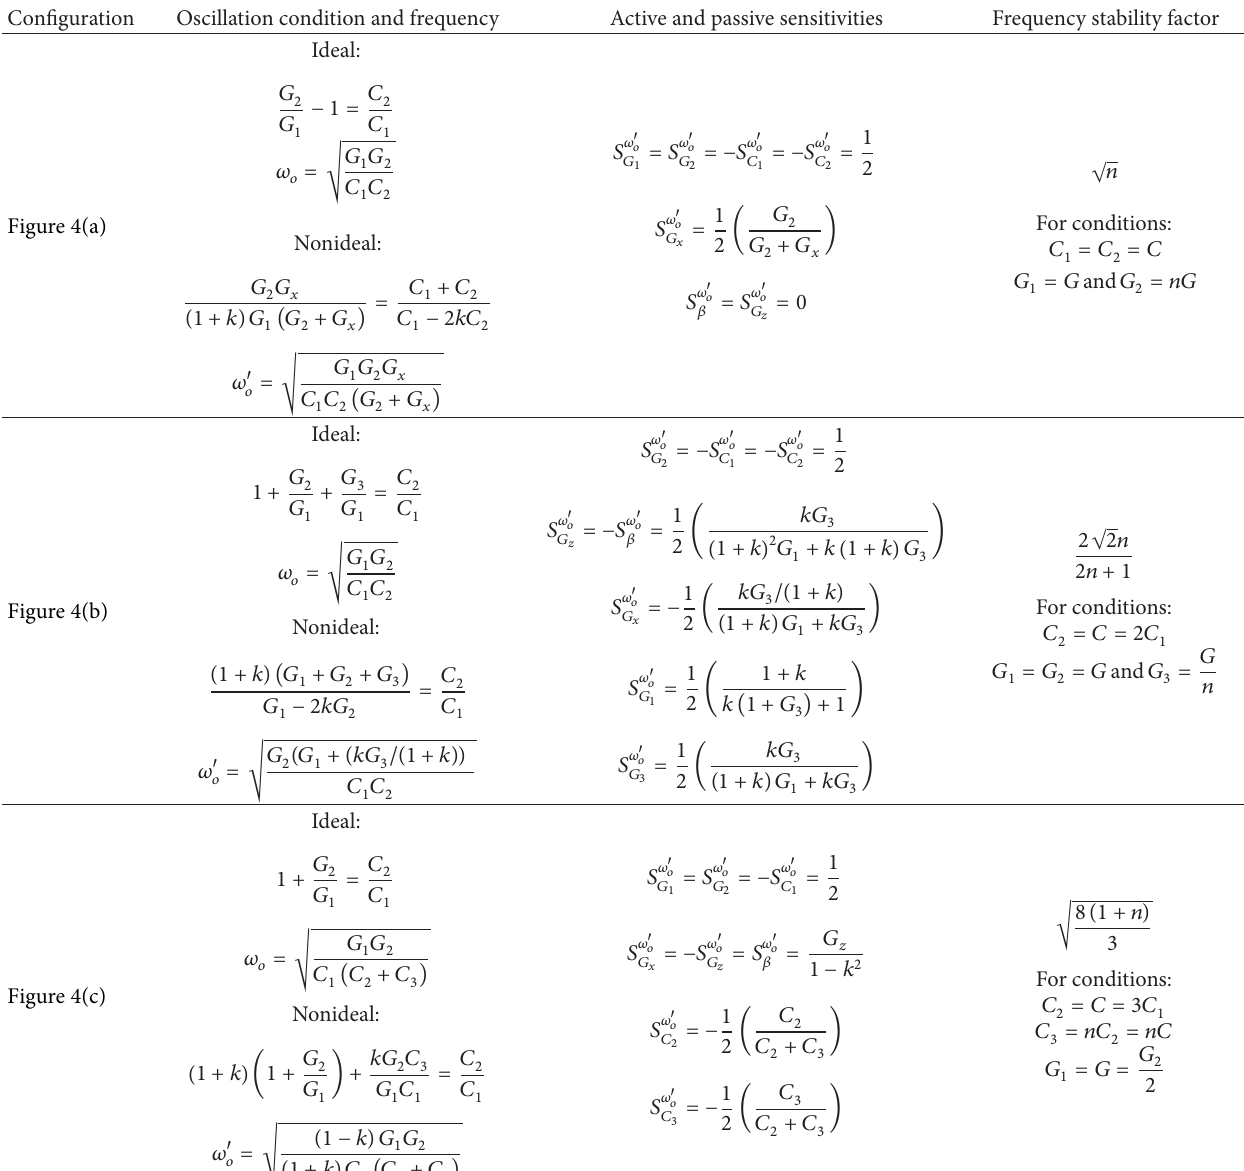
Table 2: Key equations for the proposed